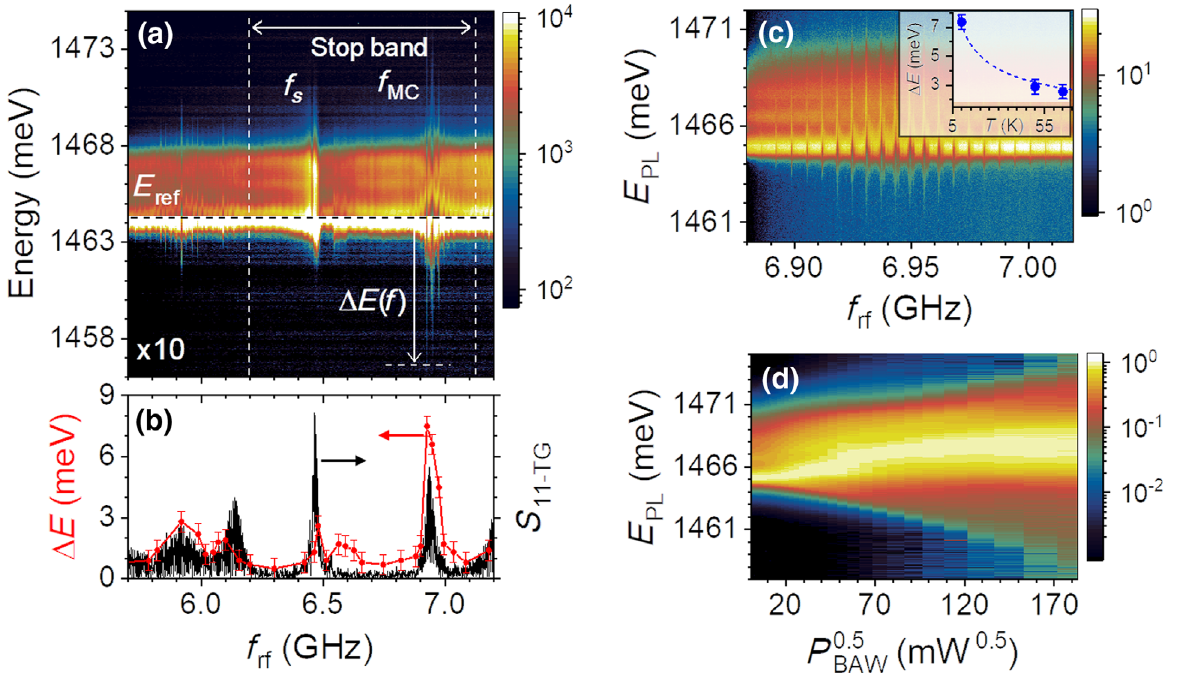
FIG. 5. Polariton-phonon interaction in a hybrid microcavity. (a) Spectral dependence of the photoluminescence on the rf frequency for sample A recorded at 10 K and the nominal rf power of 24 dBm. The acoustic stop-band limits are indicated by the vertical dashed lines. (b) Comparison of the time-gated s 11 parameter of a similar device with the acoustically induced energy modulation amplitude of ¼ 1464 . 3 meV [indicated in (a) with the horizontal black dashed line]. the comb resonances Δ E ð f Þ calculated with respect to the E ref ¼ 14 dBm applied to the BAWR at 10 K corresponding the (c) The rf-frequency dependence of the PL recorded for a fixed rf power P rf ¼ 45 mW 0 . 5 showing the effects of the frequency comb with Δ f ¼ 6 . 4 MHz. The inset coupled linear power amplitude P 0 . 5 sub BAW displays the temperature ( T ) dependence of the energy modulation amplitude Δ E . The dashed line in the inset is a guide to the eye. ¼ 6 . 9312 GHz applied to the BAWR at 10 K on P 0 . 5 (d) Dependence of the PL recorded for a fixed rf frequency f rf BAW